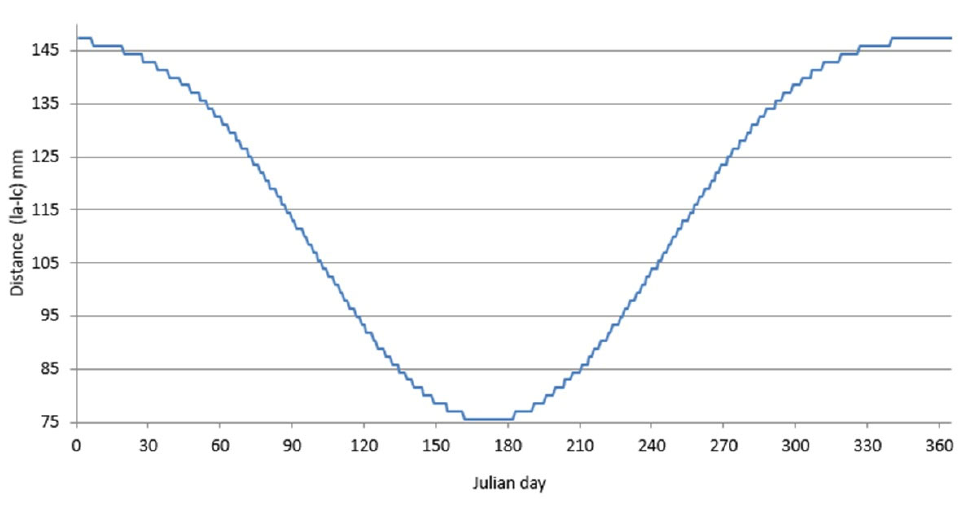
Figure 13. Evolution of 𝑙 𝐴 (cid:3398) 𝑙 𝐶 versus Julian day.